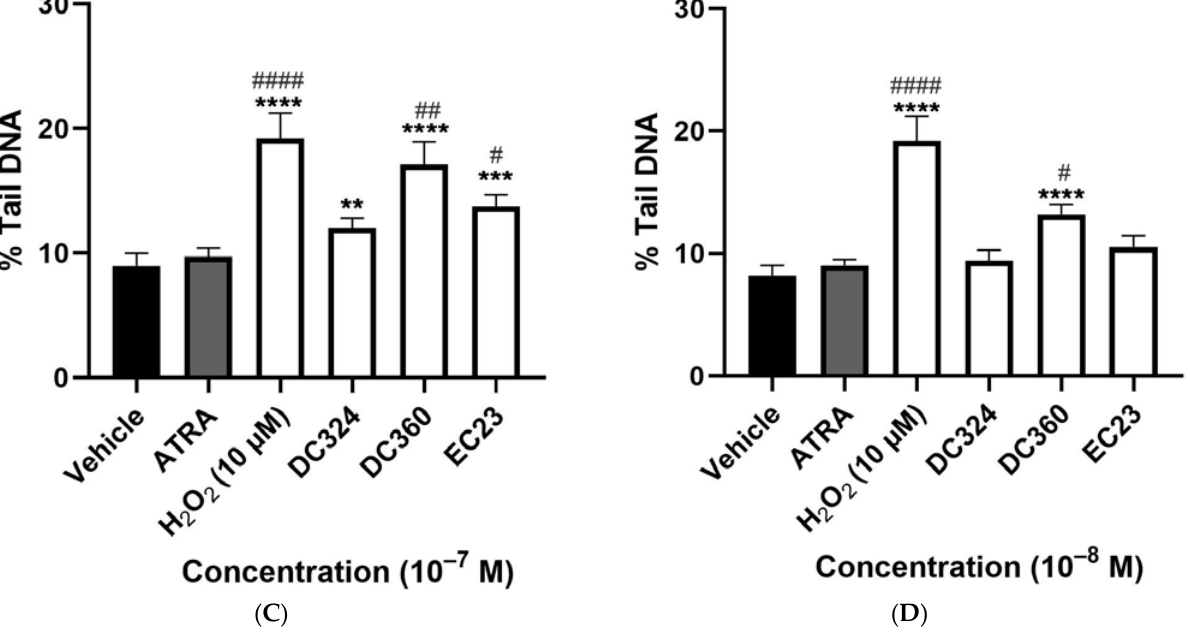
Figure 4. Degree of DNA ‐ damage following retinoid treatments. Columns represent the %tail DNA of CHO cells treated for 24 h with vehicle, 10 − 5 M H 2 O 2 as the positive control, and the retinoid compounds (10 − 5 M ( A ), 10 − 6 M ( B ), 10 − 7 M ( C ), 10 − 8 M ( D )). Each column (Except H 2 O 2 ) demonstrates the mean ± SEM of n= 100 cells derived from two independent series ( ** p < 0.01, *** p < 0.001, **** p < 0.0001 vs. vehicle), (# p < 0.05, ## p < 0.01, ### p < 0.001, #### p < 0.0001 vs. ATRA).